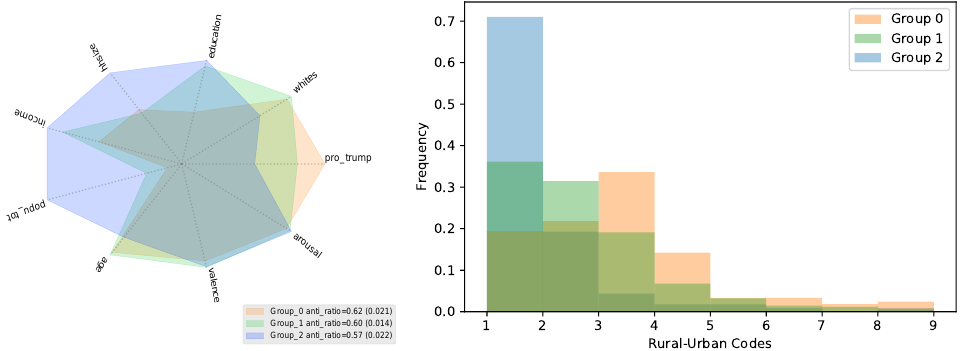
Figure 4. Descriptive statistics of the components (groups) discovered in the anti-science data. ( left ) Average value of each explanatory variable across counties assigned to that group. ( right ) Distribution of the urban–rural continuum codes for the counties assigned to each discovered group.